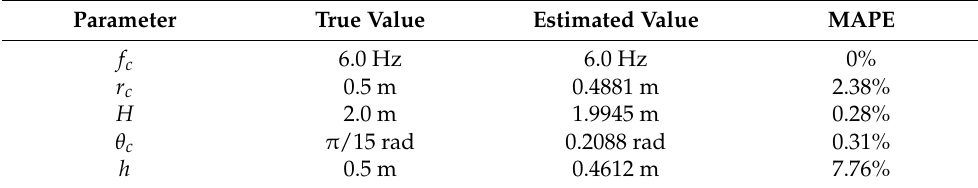
Table 2. MAPEs of precession cone-shaped target parameters (SNR = 15 dB).